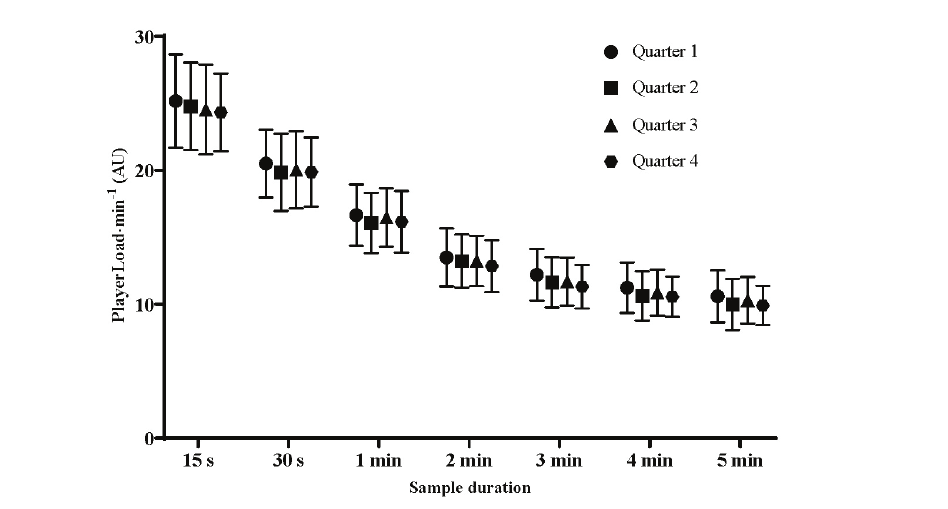
FIGURE 1. Peak intensity across basketball game quarters